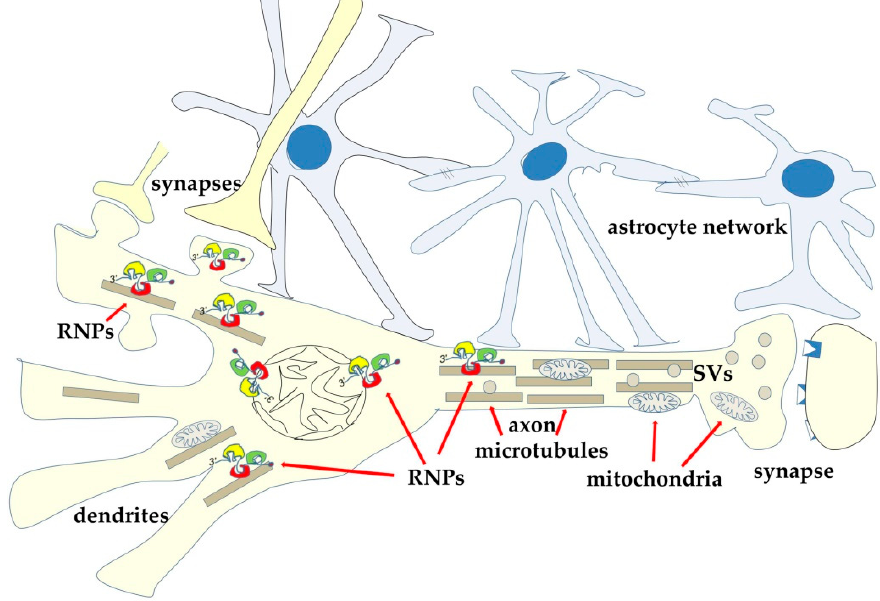
Figure 5. Neurons are highly polarized cells with only one nucleus and highly differentiated peripheries. Polarization depends on the cytoskeleton-dependent trafficking of organelles and vesicle/molecule complexes in both anterograde- and retrograde-direction. Among the transported complexes, ribonucleoprotein complexes (RNPs) have been also described. RNPs contain a variety of RNAs and RNA-binding regulatory proteins (RBPs). During their trip to the periphery mRNAs are repressed. It has been reported that, at post-synaptic sites, upon synapse activation, and largely in response to calcium waves, some RBPs undergo post-translational modifications that allow the release and translation of mRNAs. Some of the newly synthesized proteins can accumulate at the synapse, while others can shuttle back to the nucleus to modify chromatin structure and expression. At the same time, microtubules ensure transport of organelles such as mitochondria and synaptic vesicles.